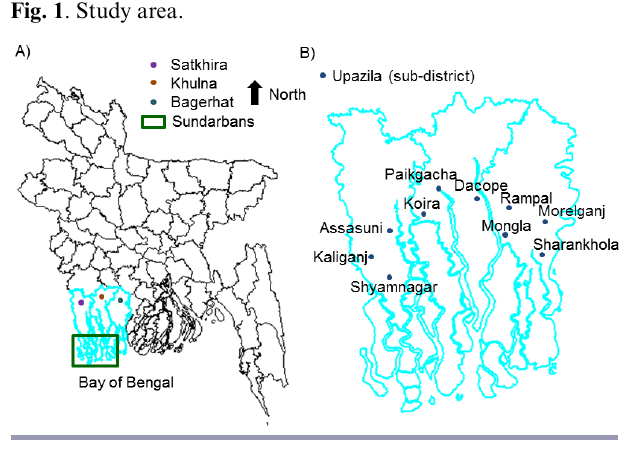
Fig. 1 . Study area.